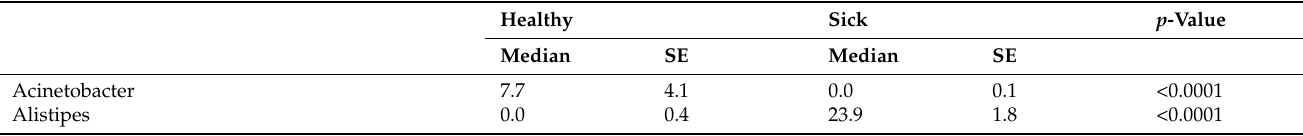
Table 3. Kruskal–Wallis non-parametric test of the relative abundances (RAs) of genera, characterizing the blood samples of healthy and sick dogs. Mean and standard deviation (SD) are reported. p -value below 0.05 denotes